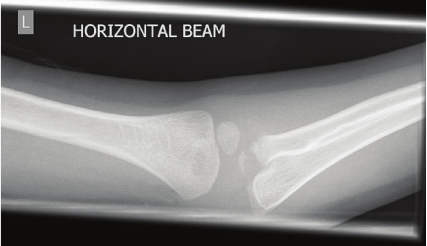
Figure 2: Anterioposterior radiograph: note the bony fragment and the medial radial head dislocation.